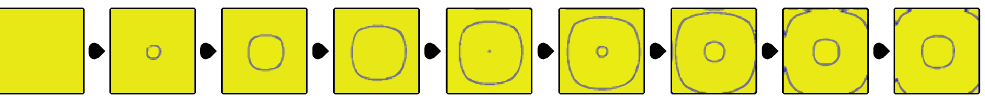
Figure 7. Ocean-surface-wave patterns on 2-D media with memristors. Although the center was stimulated, wave propagated asymmetrically due to memristive effect with same polarity over the